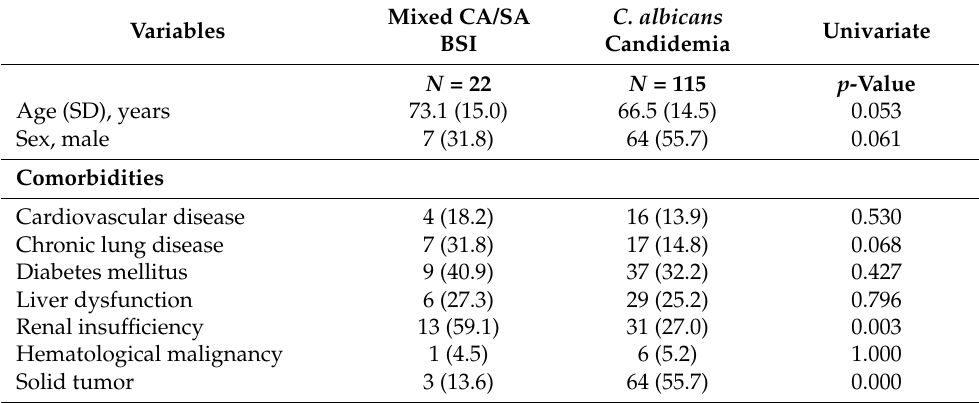
Table 1. Comparison of clinical features and outcomes for patients in mixed CA/SA BSI and C. albicans candidemia